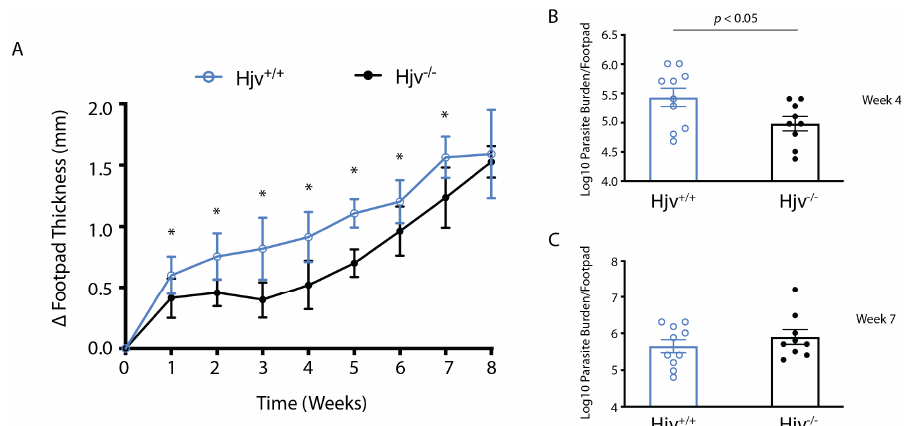
Figure 1. Hjv − / − mice exhibit relative resistance to L. major footpad infection. Hjv +/+ and Hjv − / − mice (n = 5–24 per group) were injected in hind footpads with 5 × 10 6 L major parasites: ( A ) footpads were measured weekly over 8 weeks, and thicknesses of uninfected versus infected footpads were com- pared. Footpads were collected at endpoints and used to perform a limiting dilution assay of para- site growth at 4 weeks ( B ), or 7 weeks ( C ) post-infection. Time course data are presented as mean ± SD, while log 10 number of parasites per footpad are presented as mean ± SEM. * indicates p <0.05. Popliteal lymph nodes, the draining lymph nodes that are accessible to the parasite during footpad infections, were collected and evaluated for cytokine and chemokine gene expression. In both mouse models, cytokine gene expression appeared to increase over time. It was significantly higher than in mesenteric lymph nodes (MLN) used as unin- fected control tissues, except for Il6 expression, which remained at the baseline (Figure 2A–D). Chemokine expression remained largely unaffected in lymph nodes, with only a slight increase in Ccl2 expression at 7 weeks post-infection (Figure 2E–H). No genotype- specific differences were observed, suggesting that cytokine and chemokine expression in the draining lymph node is not the cause of the delayed parasite growth observed in foot- pads.